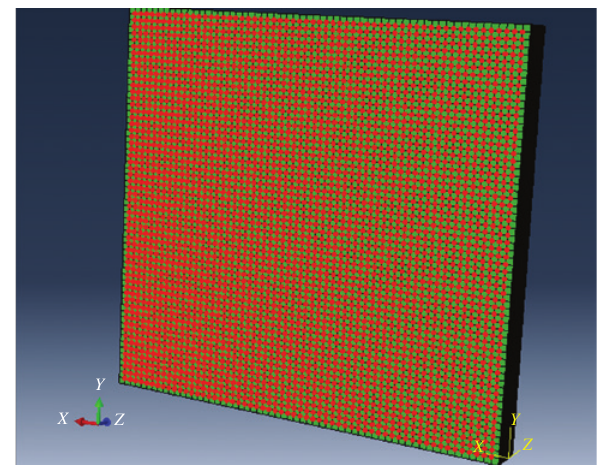
Figure 10: Constrained nodes on a face.